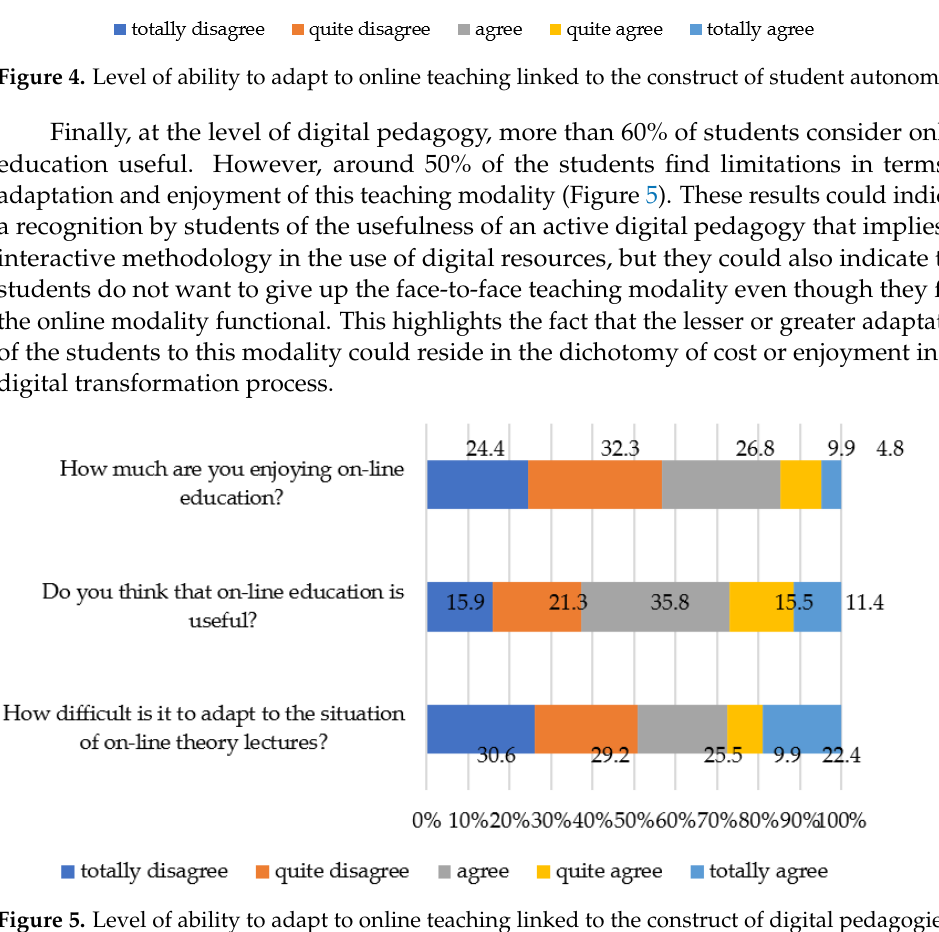
Figure 5. Level of ability to adapt to online teaching linked to the construct of digital pedagogies.